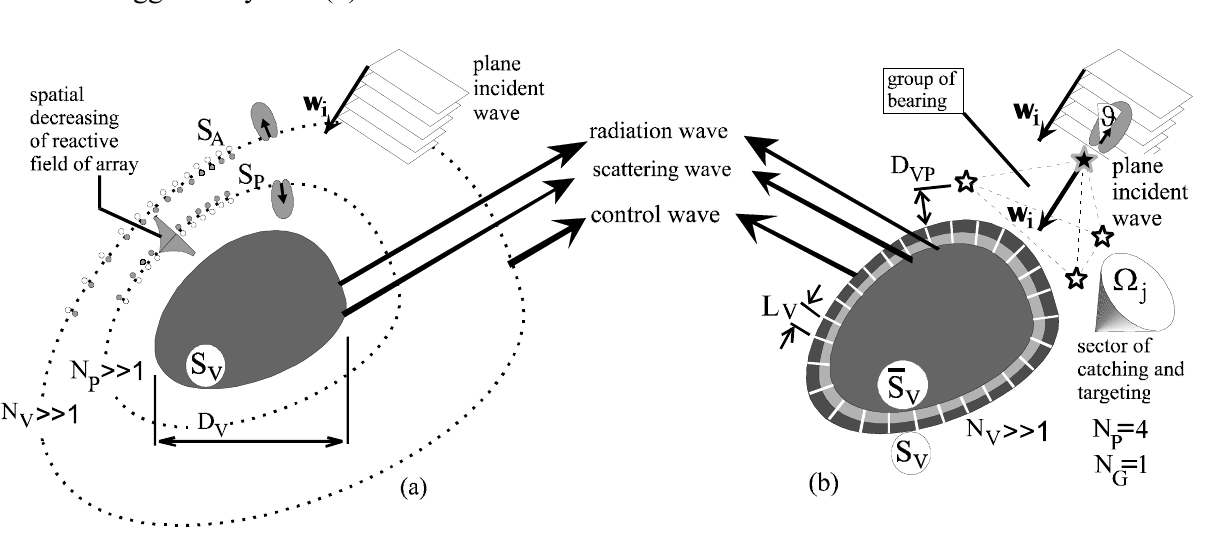
Figure 16. Comparison of method of G.D. Malyuzhinets (a) with the simplest version of the suggested system